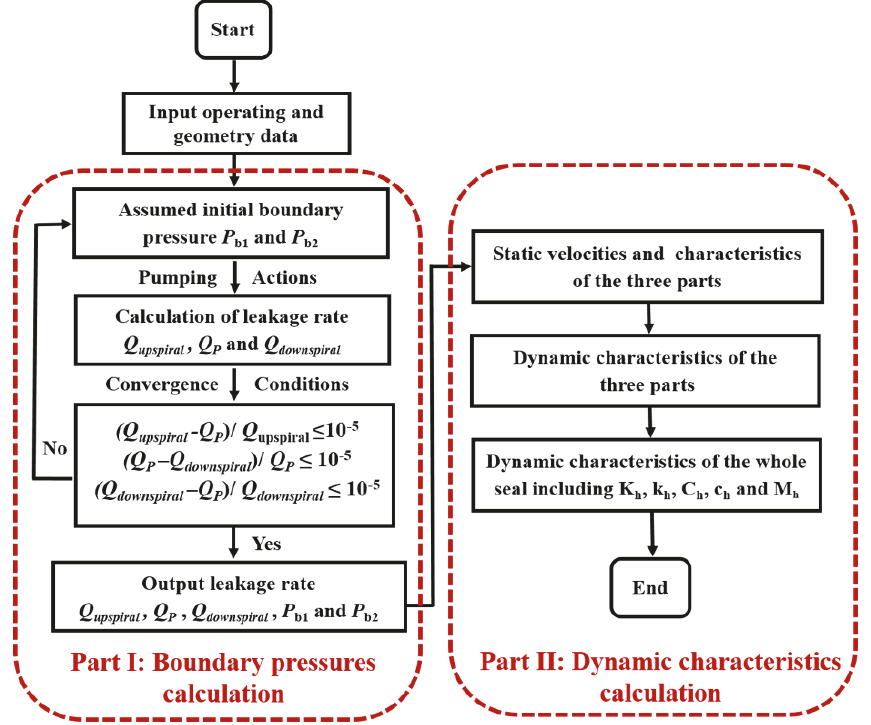
Figure 4: Procedure chart of the rotordynamic characteristics calculation.